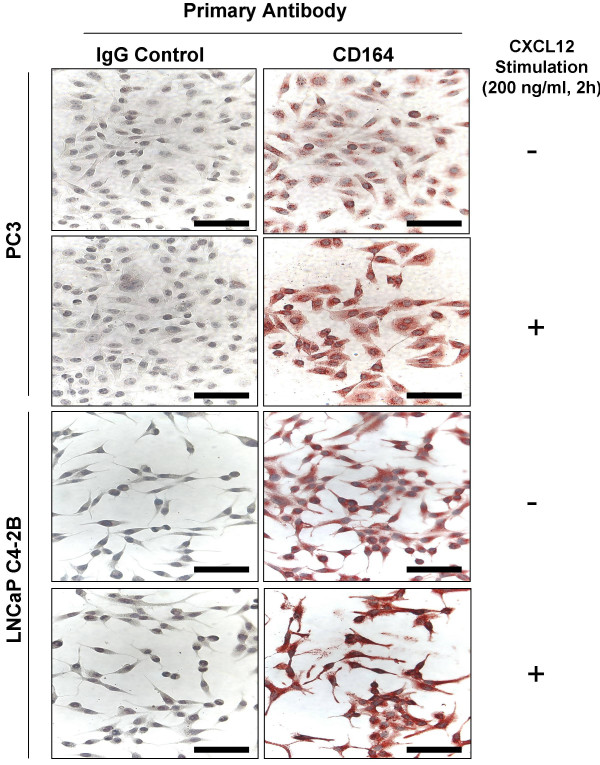
Expression of CD164 in prostate cancer cell lines is responsive to CXCL12. To determine if the prostate cancer cells express CD164 protein, and whether its expression was altered by CXCL12, PC3 and LNCaP C4-2B cells were treated with PBS or 200 ng/ml CXCL12 for 2 h, fixed and stained with anti-CD164 mAb or an IgG isotype matched control, and photographed at 40X. Scale bars = 100 μm. The cancer cells demonstatrate perinuclear and cytoplasmic expression of CD164 in nearly all of the cells under basal conditions, and abundantly express CD164 following CXCL12 stimulation.